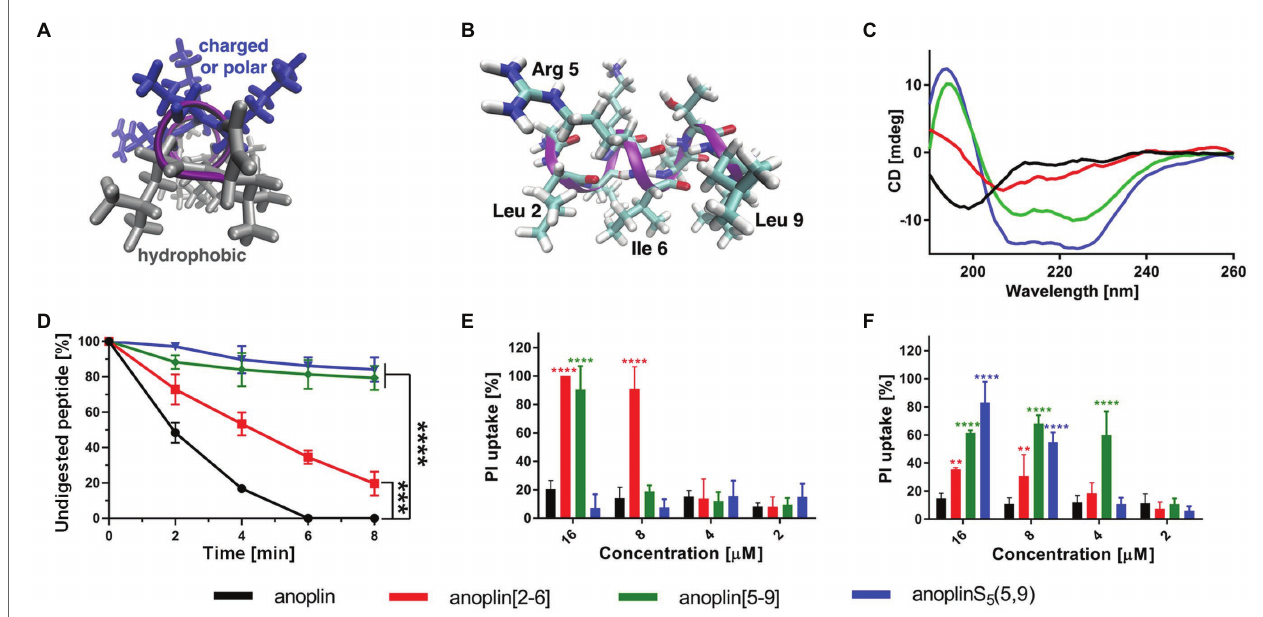
FIGURE 1 | (A) The model of the helical structure of anoplin. The helix-forming backbone is marked in magenta. The helical-wheel view from the C-terminus showing the amphipathic character of anoplin. (B) The side view of anoplin denoting the residues that were substituted with staples. (C) CD spectra of anoplin and its analogs in the phosphate buffer (10 mM, pH 7.0). (D) Digestion of the peptides by trypsin as a function of time. The remaining peptide amounts were determined by RP-HPLC. (E) Permeabilization assay of E. coli K12 MG1655 and (F) S. aureus ATCC 29213 using propidium iodide (PI) indicated as the percentage of PI uptake after 30 min of incubation. Error bars represent the standard error of the mean; n = 3. Statistical significance between the unmodified anoplin and the modified peptides is denoted by **** p < 0.0001, *** p < 0.001, and ** p < 0.01. Otherwise, the differences are not statistically significant.